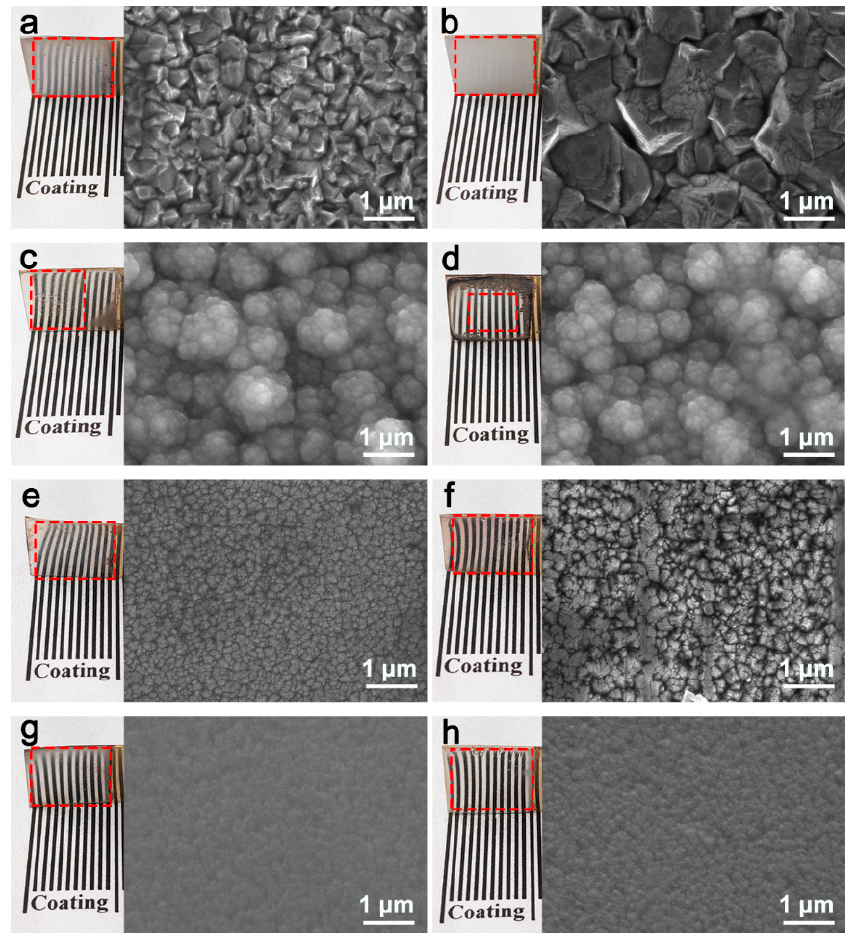
Figure 6. Optical images and SEM images of Al coatings obtained from AlCl 3 -EMIC ionic liquids containing ( a , b ) no and 6 mM of ( c , d ) 2-cyanopyridine, ( e , f ) 3-cyanopyridine, and ( g , h ) 4-cyanopyridine, with a current density of 10 mA/cm 2 for ( a , c , e , g ) 1 min and ( b , d , f , h ) 10 min. The SEM images of the coated samples are at a 20,000× magnification.